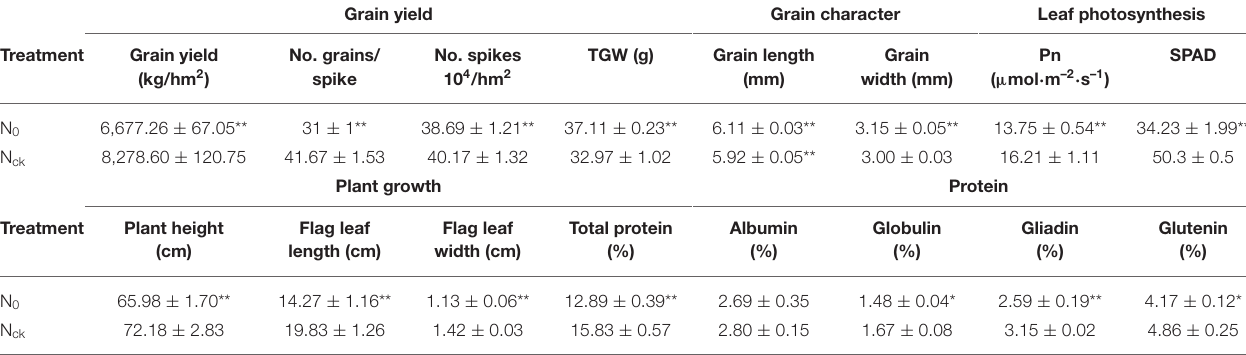
TABLE 2 | Comparison of yield, plant growth, photosynthesis, and quality indicators of wheat grown under N0 and Nck conditions. Grain yield Grain character Leaf photosynthesis Treatment